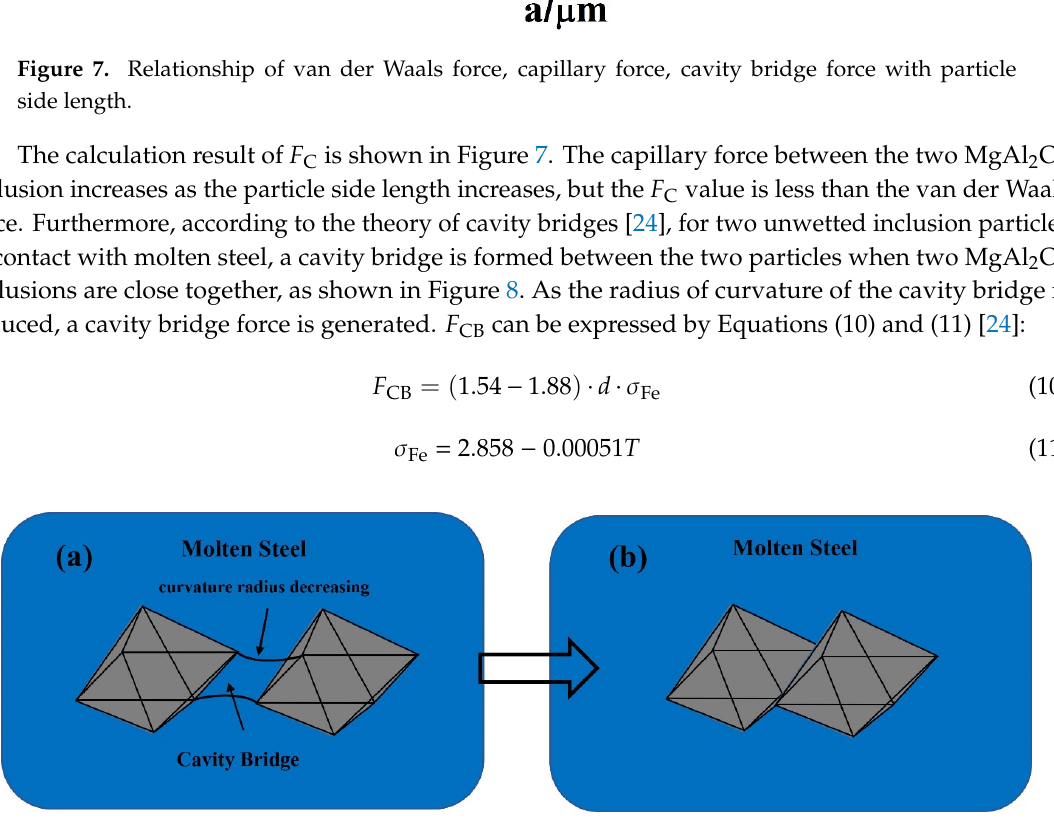
Figure 8. Schematic diagram of cavity bridge force. ( a ) Cavity bridge force formation process; ( b ) Aggregation of MgAl 2 O 4 inclusion.